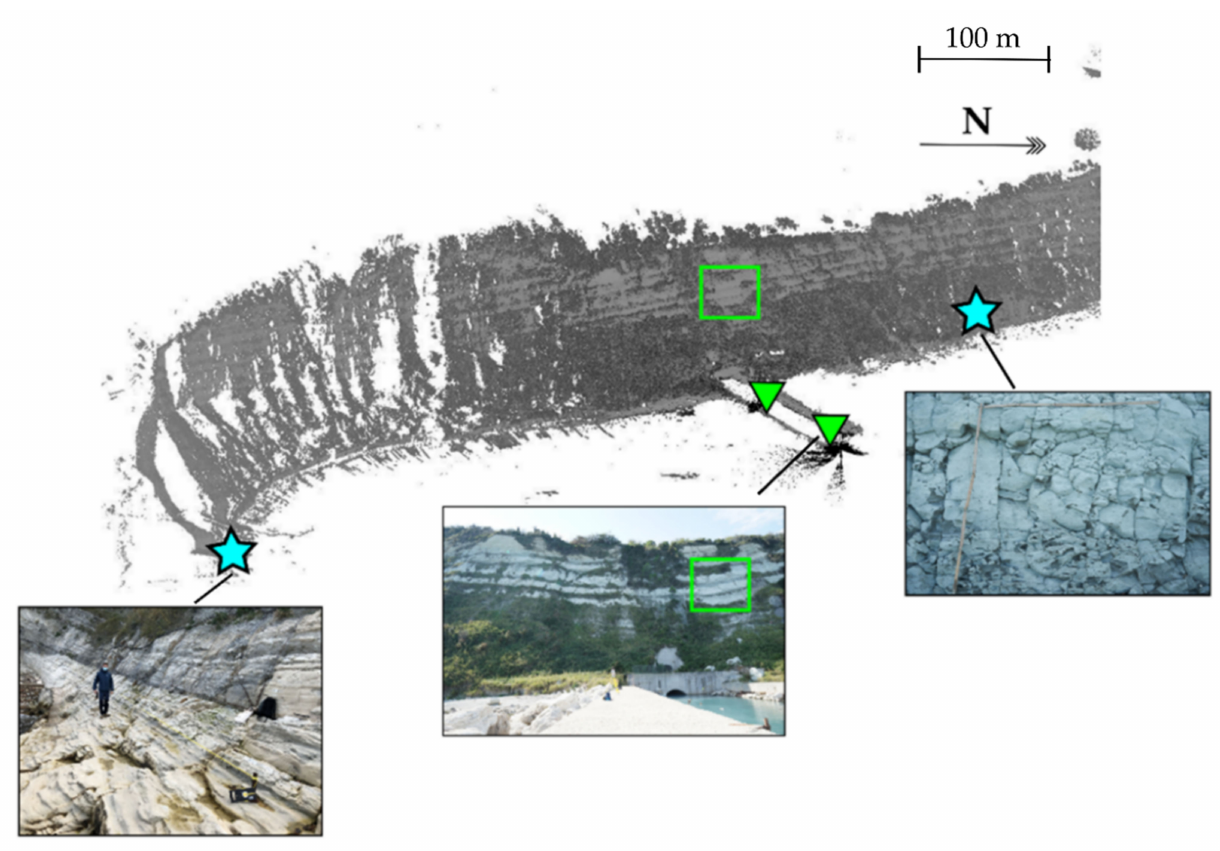
Figure 2. Point cloud obtained by the TLS surveys, with the position of the traditional geomechanical survey (light blue stars) and TLS survey (green